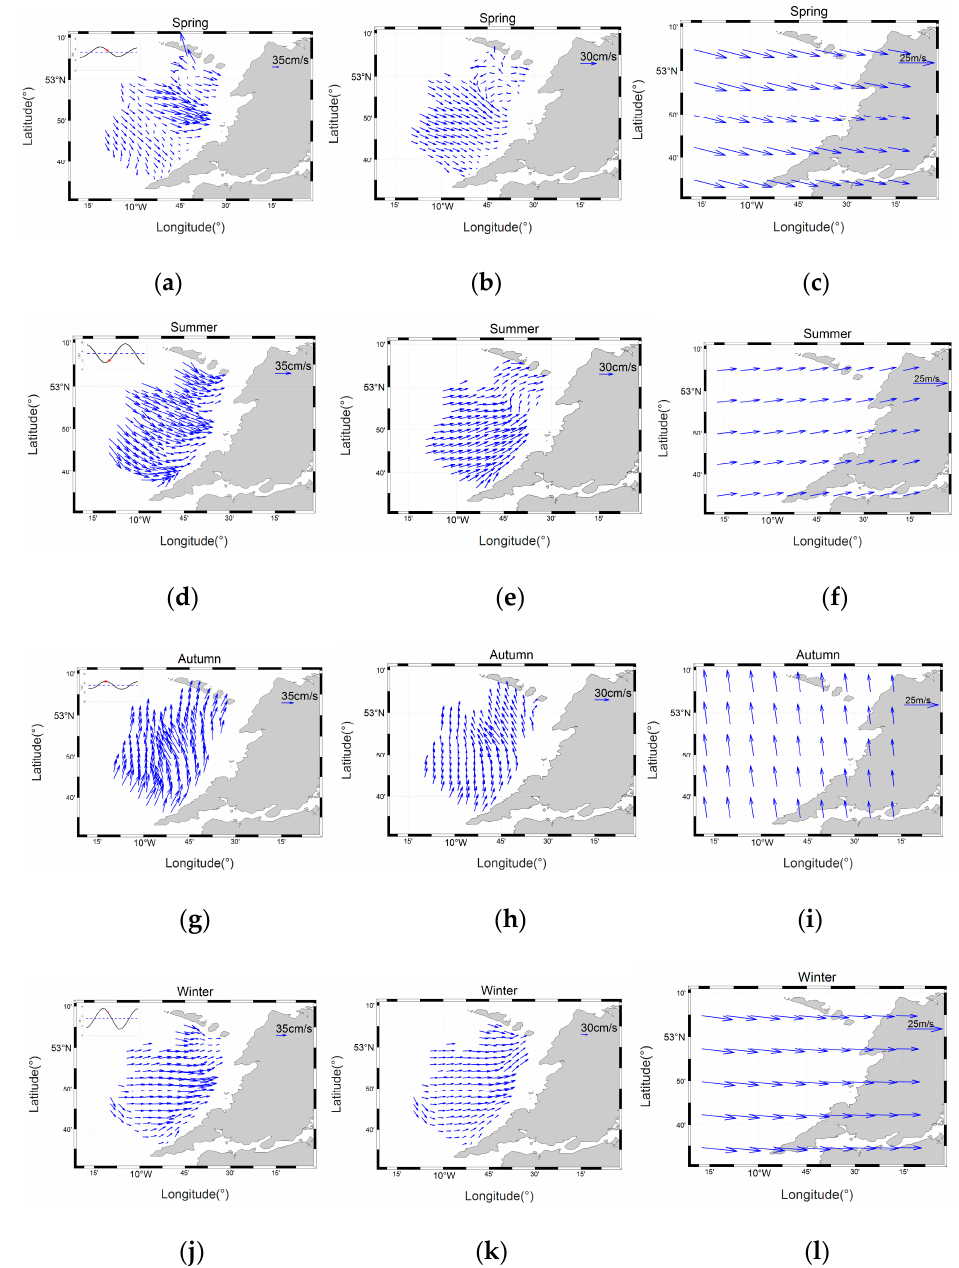
Figure 13. Residual surface current vectors and HFR current vector fields corresponding to the maximum atmospheric wind fields during four seasons. ( a , d , g , j ) are original currents from HFR; ( b , e , h , k ) are residual currents; ( c , f , i , l ) are wind vectors. The panels at the top left of ( a , d , g , j ) are the tidal phrase corresponding to the maximum wind time (the red dot in the top left subfigure is the tide level at the corresponding analysis time).